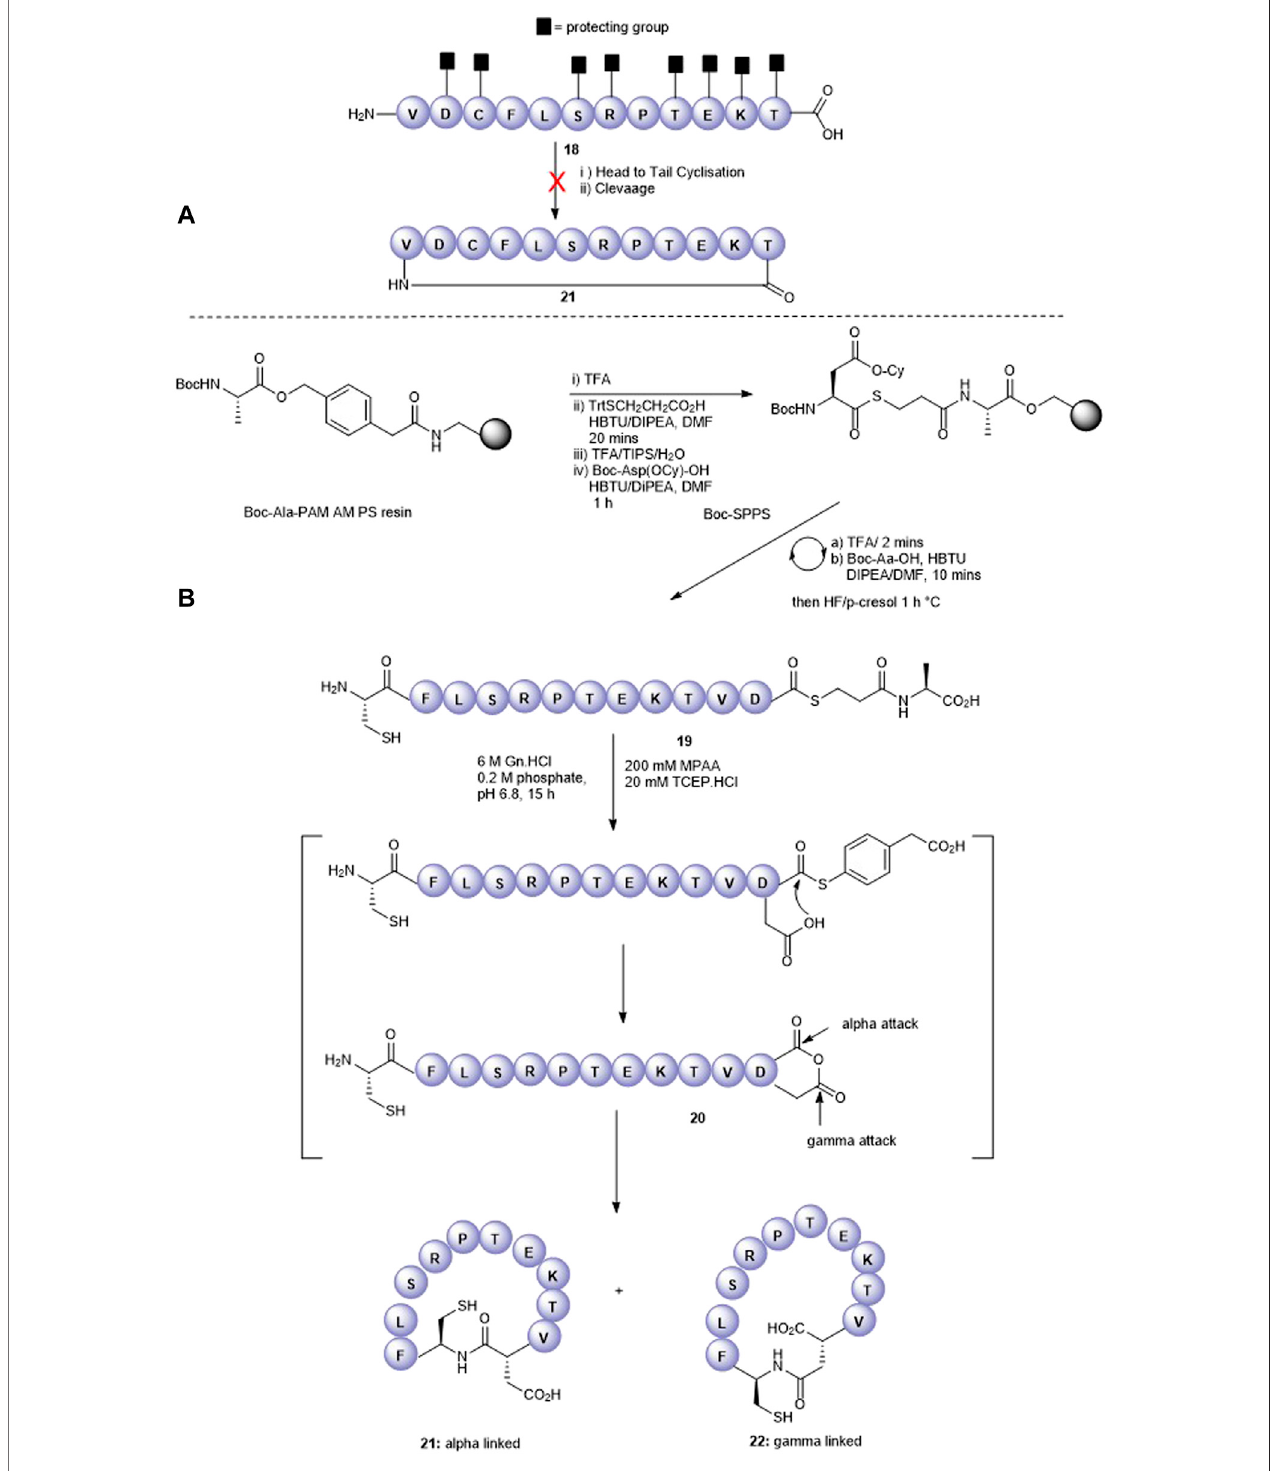
FIGURE 3 | Unsuccessful cyclization attempt to prepare cyclic peptide5 21 (A) and the successful strategy employing native chemical ligation (B) .